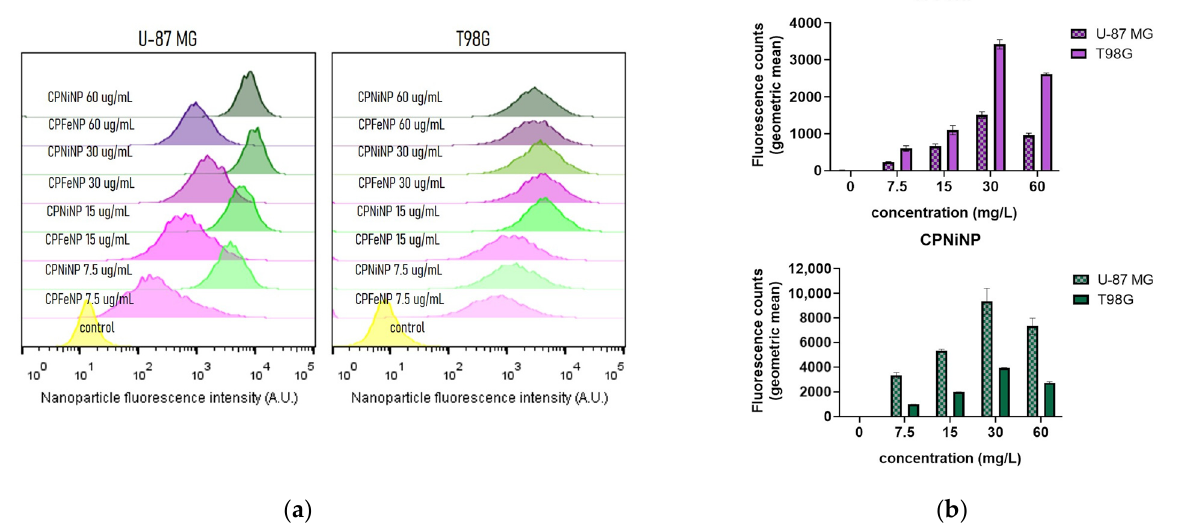
Figure 2. IONP-doped CPN cell uptake quantification by flow cytometry. ( a ) Cell fluorescence histograms obtained from U-87 MG and T98G GBM cell lines after 24 h nanoparticle incubation time. ( b ) Bar graphs representing semi quantification (geometric mean fluorescence intensity) of cell fluorescence (associated with particle uptake) at varying particle concentrations for CPFeNP (upper panel) and CPNiNP (lower panel)